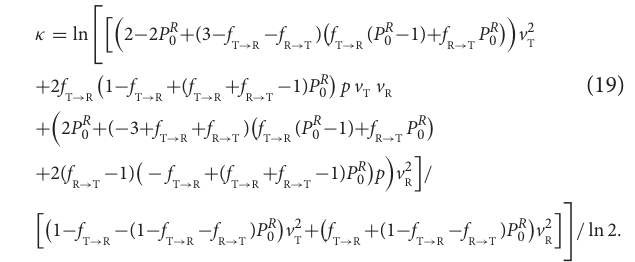
curves merge and follow the analytical prediction Equation